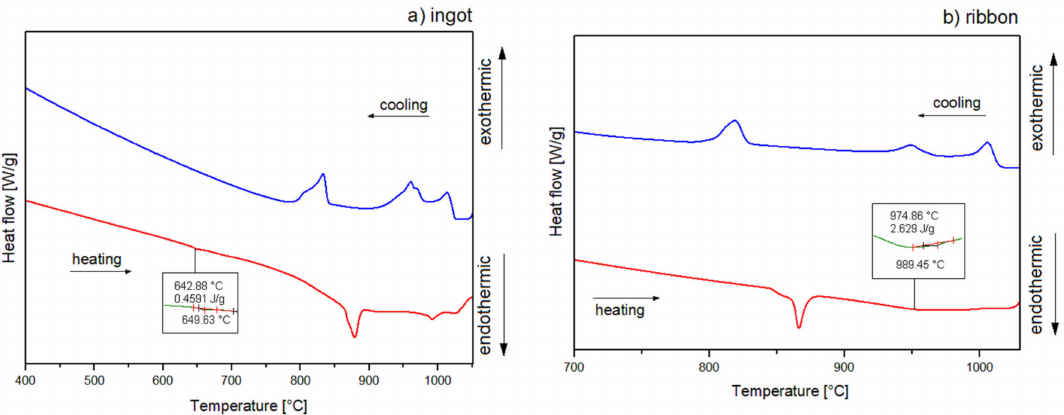
Figure 6. Differential scanning calorimetry (DSC) curves of Al 65 Cu 20 Fe 15 alloy for ( a ) ingot, ( b ) ribbon, 10 ◦ /min.